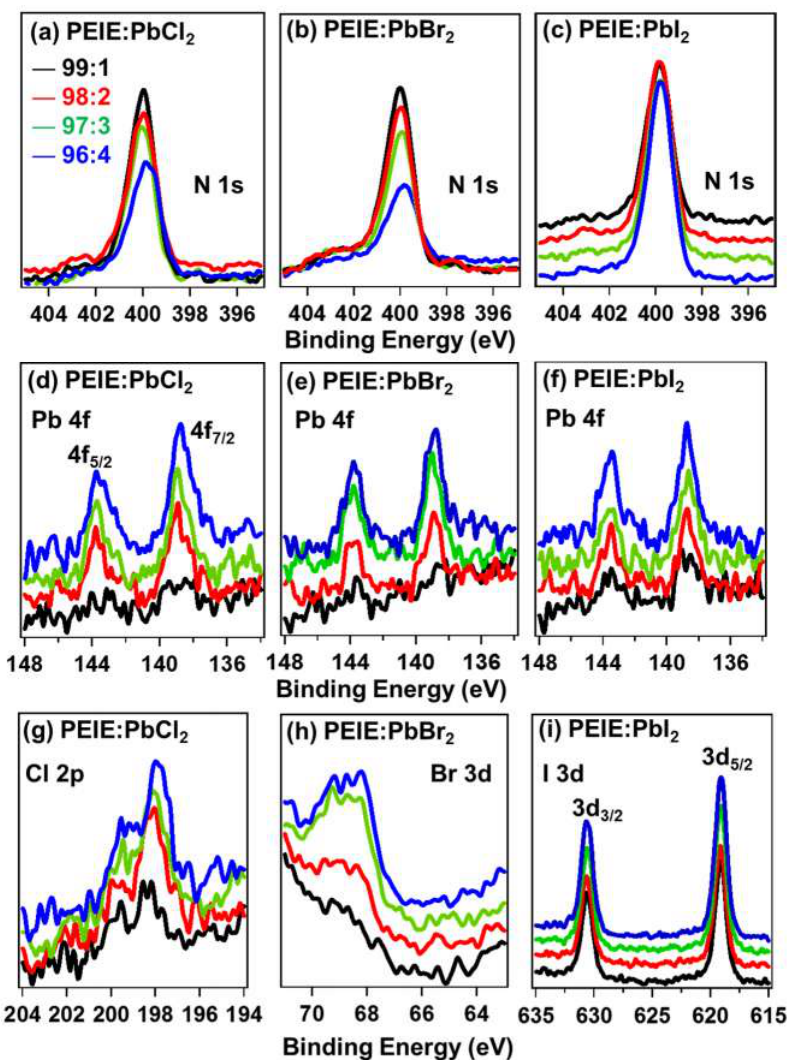
Figure 3. Quantitative analysis of XPS results. Nitrogen 1s emission levels for ( a ) PEIE:PbCl 2 , ( b ) PEIE:PbBr 2 , and ( c ) PEIE:PbI 2 films, Lead 4f emission levels for ( d ) PEIE:PbCl 2 , ( e ) PEIE:PbBr 2 , and ( f ) PEIE:PbI 2 films and Chlorine 2p emission levels for ( g ) PEIE:PbCl 2 , Bromine 3d emission levels for ( h ) PEIE:PbBr 2 , and Iodine 3d emission levels for ( i ) PEIE:PbI 2 films as a function of the organic and inorganic composite ratio.